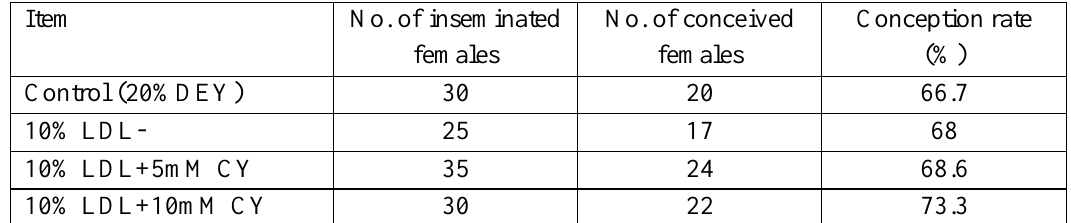
Table 7: Conception rate of Friesian cows inseminated with frozen semen cryopreserved in different concentrations of Duck egg yolk LDL and Cysteine: